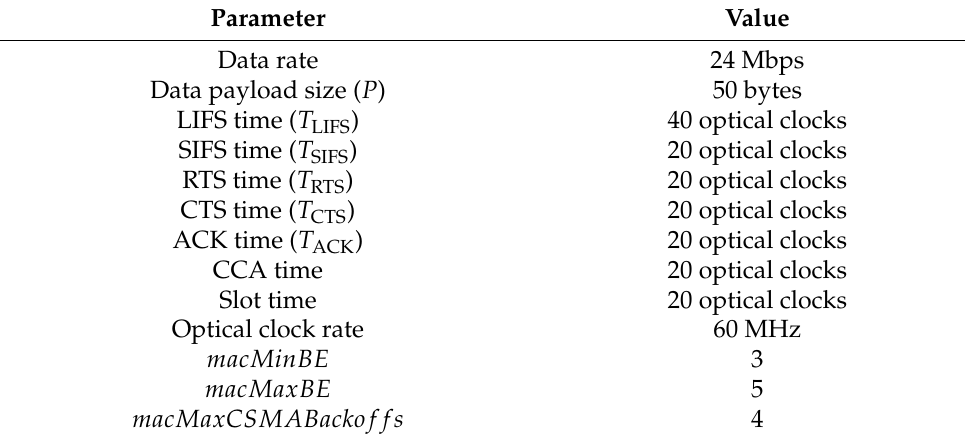
Table 1. System parameters.